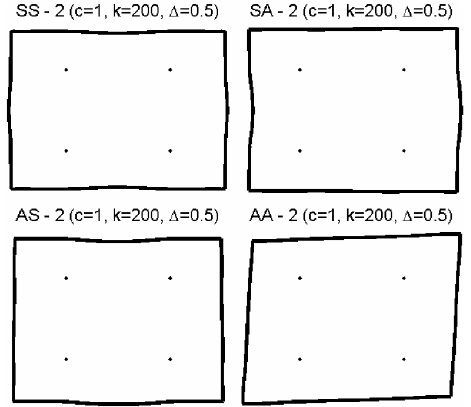
Fig. 6. Mode shapes (2 nd mode, Case 2, c = 1, ∆ = 0.5).